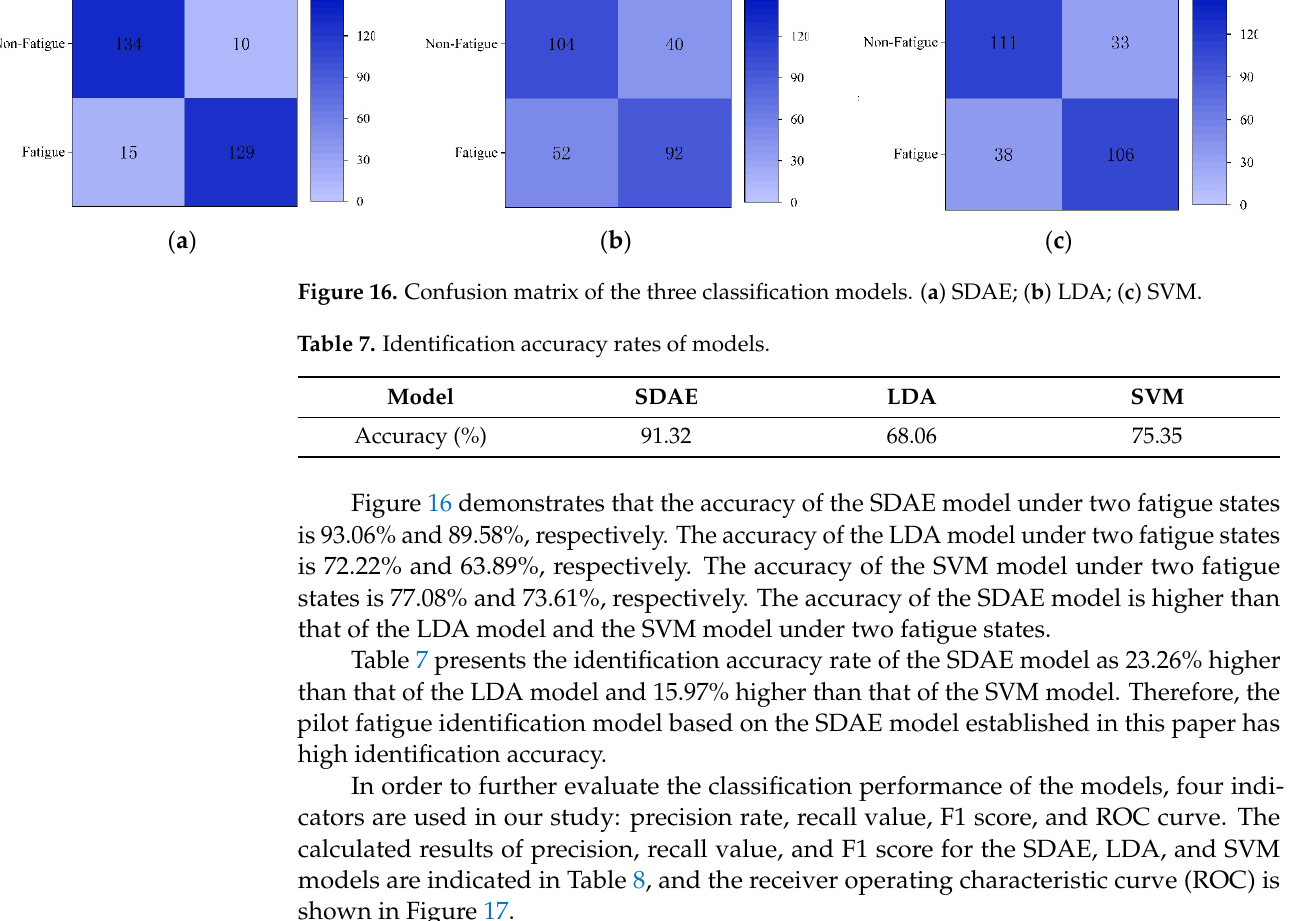
Table 8. Performance evaluation results of classification